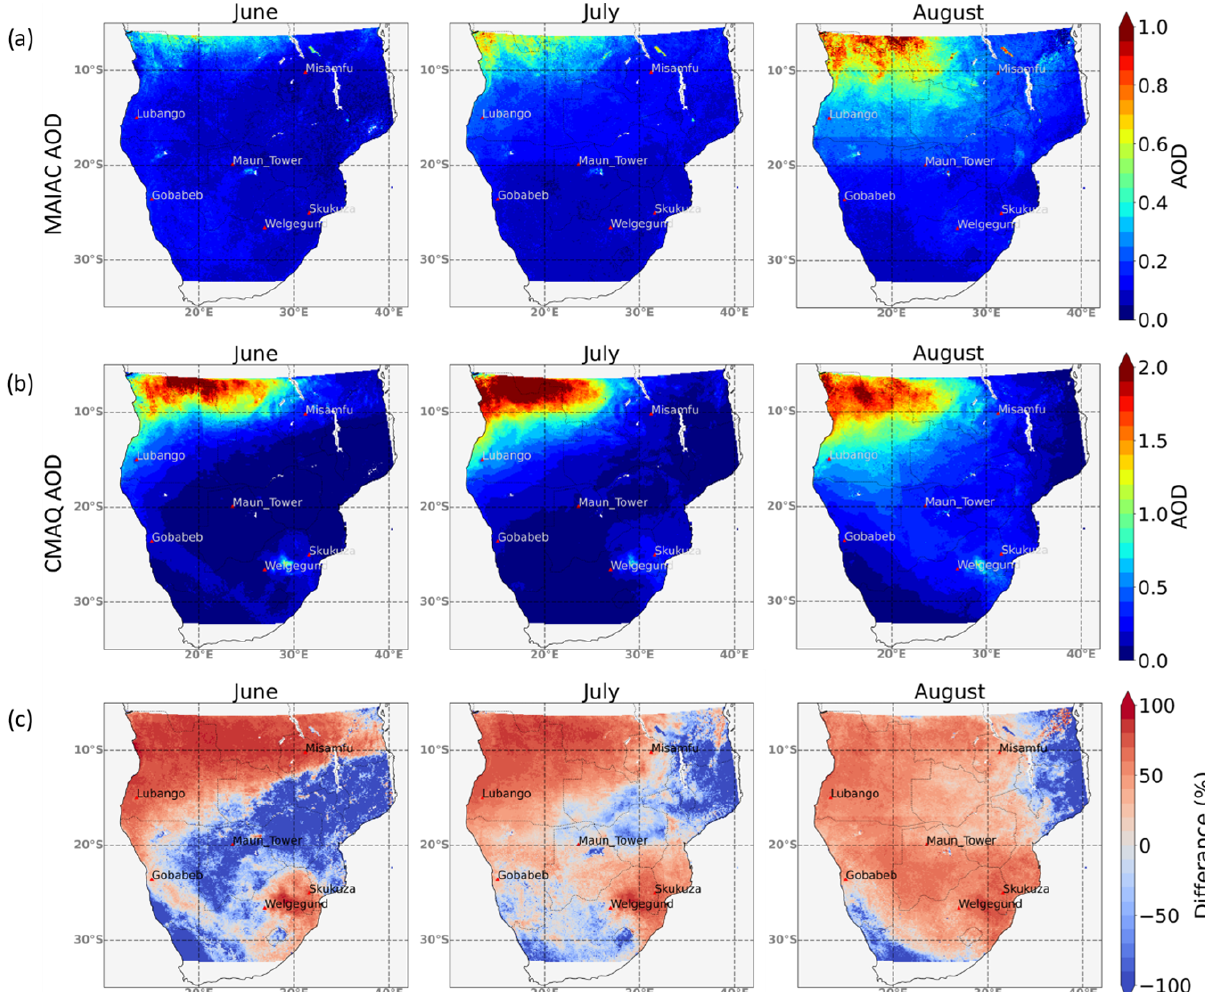
Figure D2. Mapped mean monthly AOD at 550nm from (a) the MAIAC satellite product and (b) CMAQ simulations (note the colour scale differences between a and b ) during the simulation period from 15 June to 29 August 2019. Panel (c) shows the percentage difference between MAIAC and CMAQ